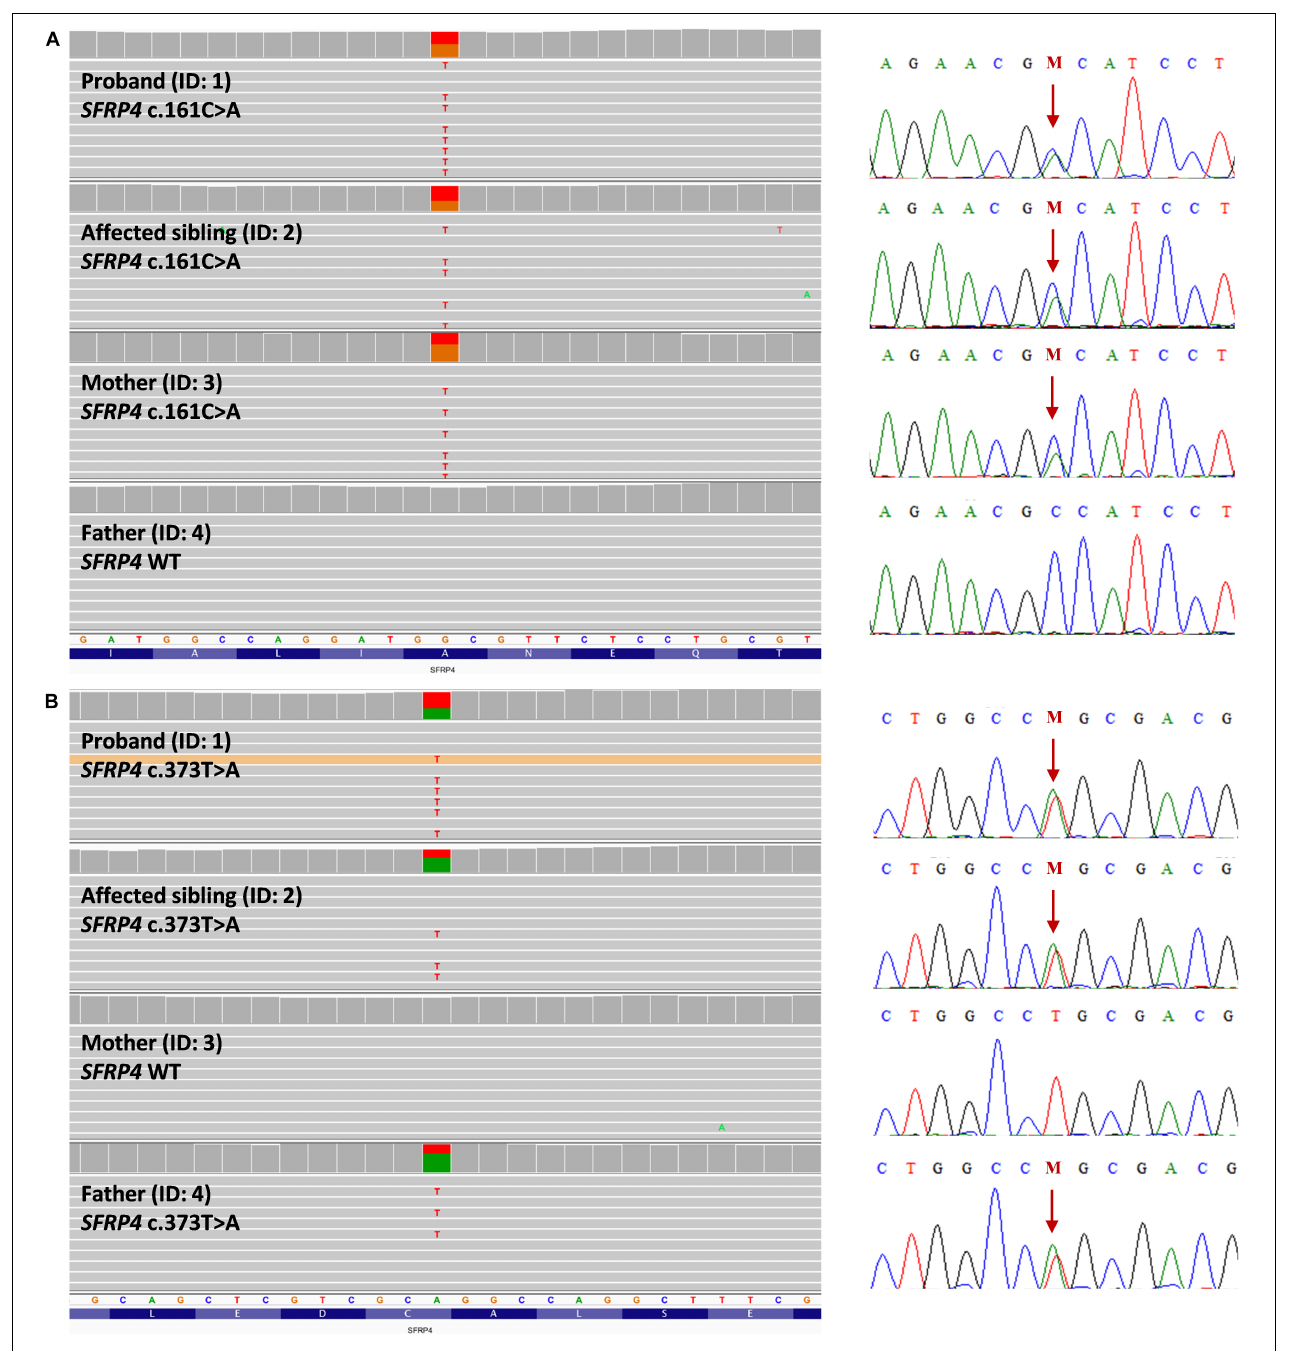
FIGURE 2 | Representation of compound heterozygous SFRP4 mutations identified in the examined family by means of whole genome sequencing (WGS). The proband (ID: 1) and her brother (ID: 2) were both demonstrated to carry two missense heterozygous variants c.161C > A and c.373T > A. Mutation c.161C > A (A) was present in heterozygosity in the unaffected mother, whereas variant c.373T > A (B) was shown in heterozygosity in the healthy father. Targeted Sanger sequencing validation of WGS results was represented by corresponding electropherograms for (A,B) . Mutations were depicted with “M” and indicated by an arrow.